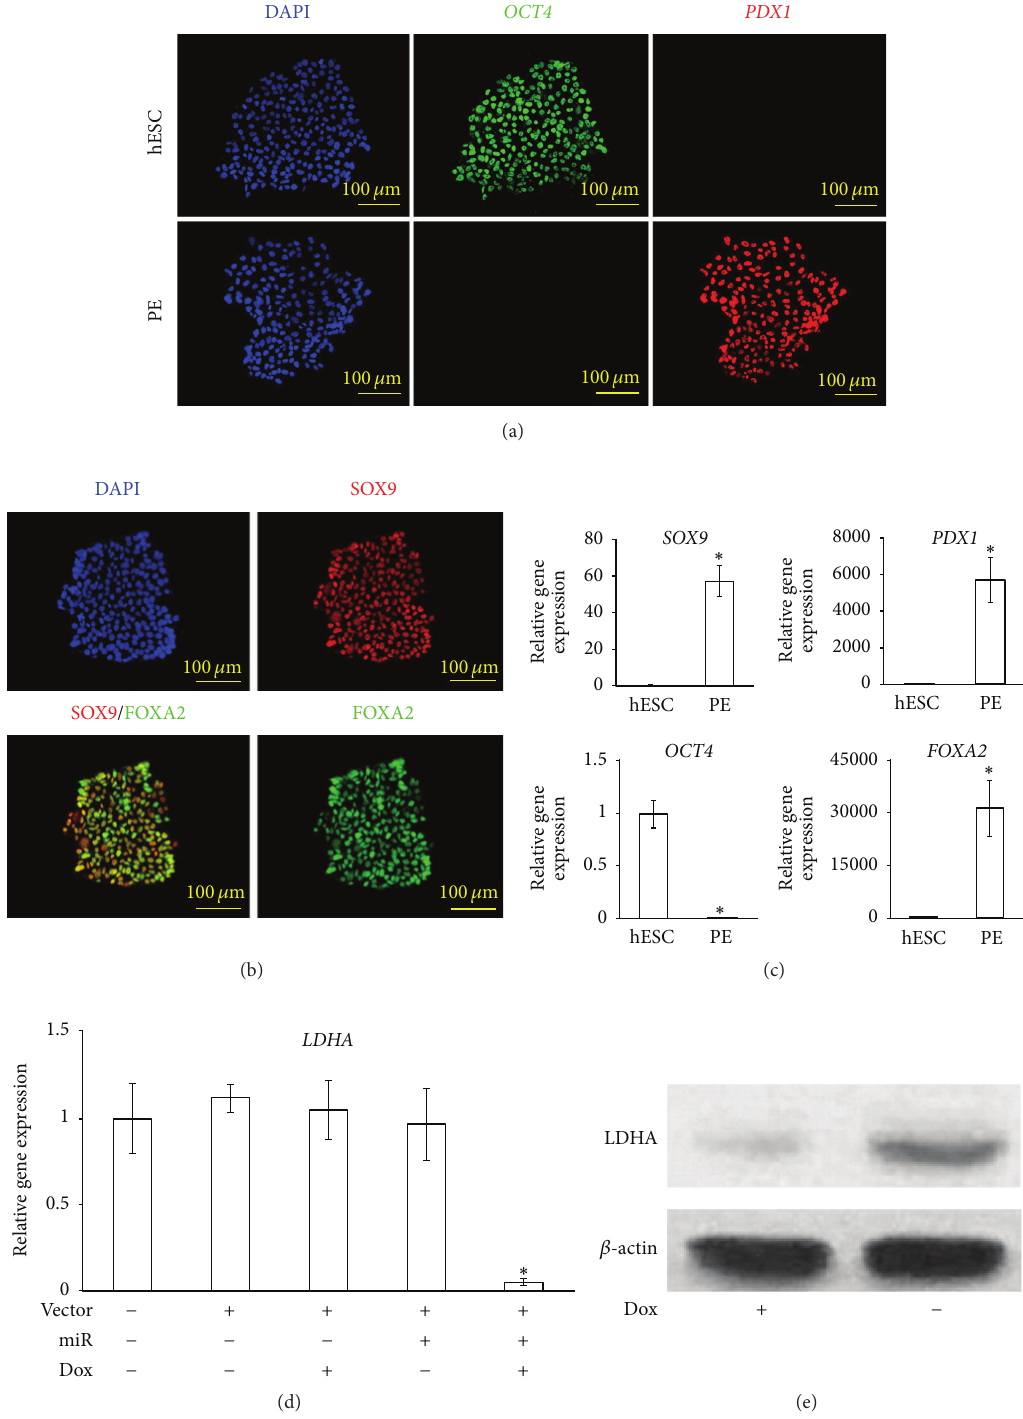
Figure 2: Characterization of hESC-derived PE and miR function. (a) miR-590-3p transfected H1 ESCs (miR-H1-ESC) were differentiated to pancreatic endoderm (PE) (see Section 2). Cells of undifferentiated miR-H1-ESC and differentiated PE (miR-PE) were subject to immunofluorescence analysis and stained for DAPI, OCT4, and PDX1. (b) miR-PE stained for DAPI, SOX9, and FOXA2. (c) Relative gene expression of OCT4 , PDX1 , FOXA2 , and SOX9 from miR-hESCs and miR-PE. All values are given as mean; error bar represents standard error. ∗ 𝑝 < 0.05 , compared with undifferentiated H1 hESC. (d) Real-time qPCR results of LDHA expression in H1-ESC with and without miR-590-3p transfection and doxycycline induction. All values are given as mean; error bar represents standard error. ∗ 𝑝 < 0.05 , compared with nontransduced H1 hESC. (e) Western blot analysis of LDHA in miR-PE cells with/without doxycycline